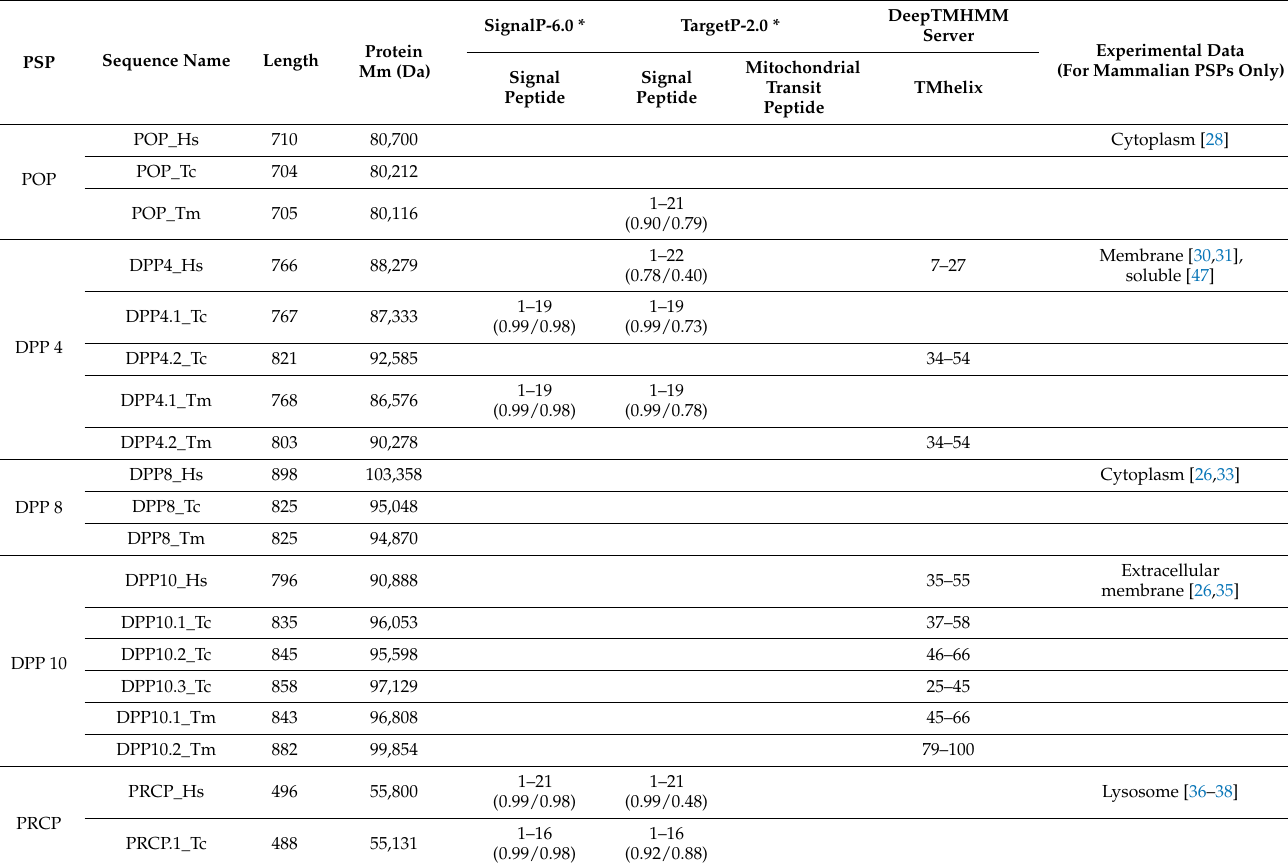
Table 5. Analysis of the localization domains of